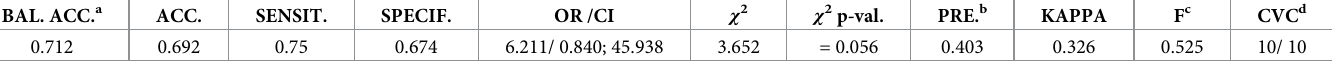
Table 3. Test set results obtained for the ACTN3 –PPARGC1A –PPAR α –SNAP-25 epistatic model selected to maximize balanced accuracy in 10-fold cross validation. BAL. ACC. a ACC.